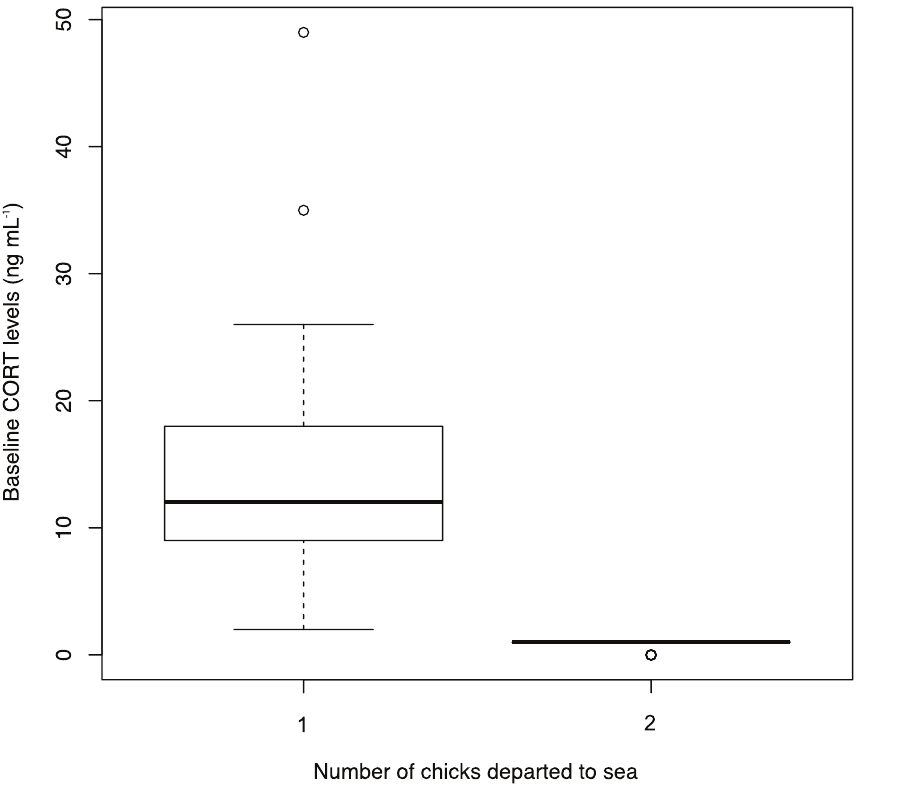
Figure 4. Baseline CORT levels (ng mL 2 1 ) of 38 ancient murrelets by number of chicks that departed to sea. All samples were taken at the end of incubation period at Reef Island in 2008.